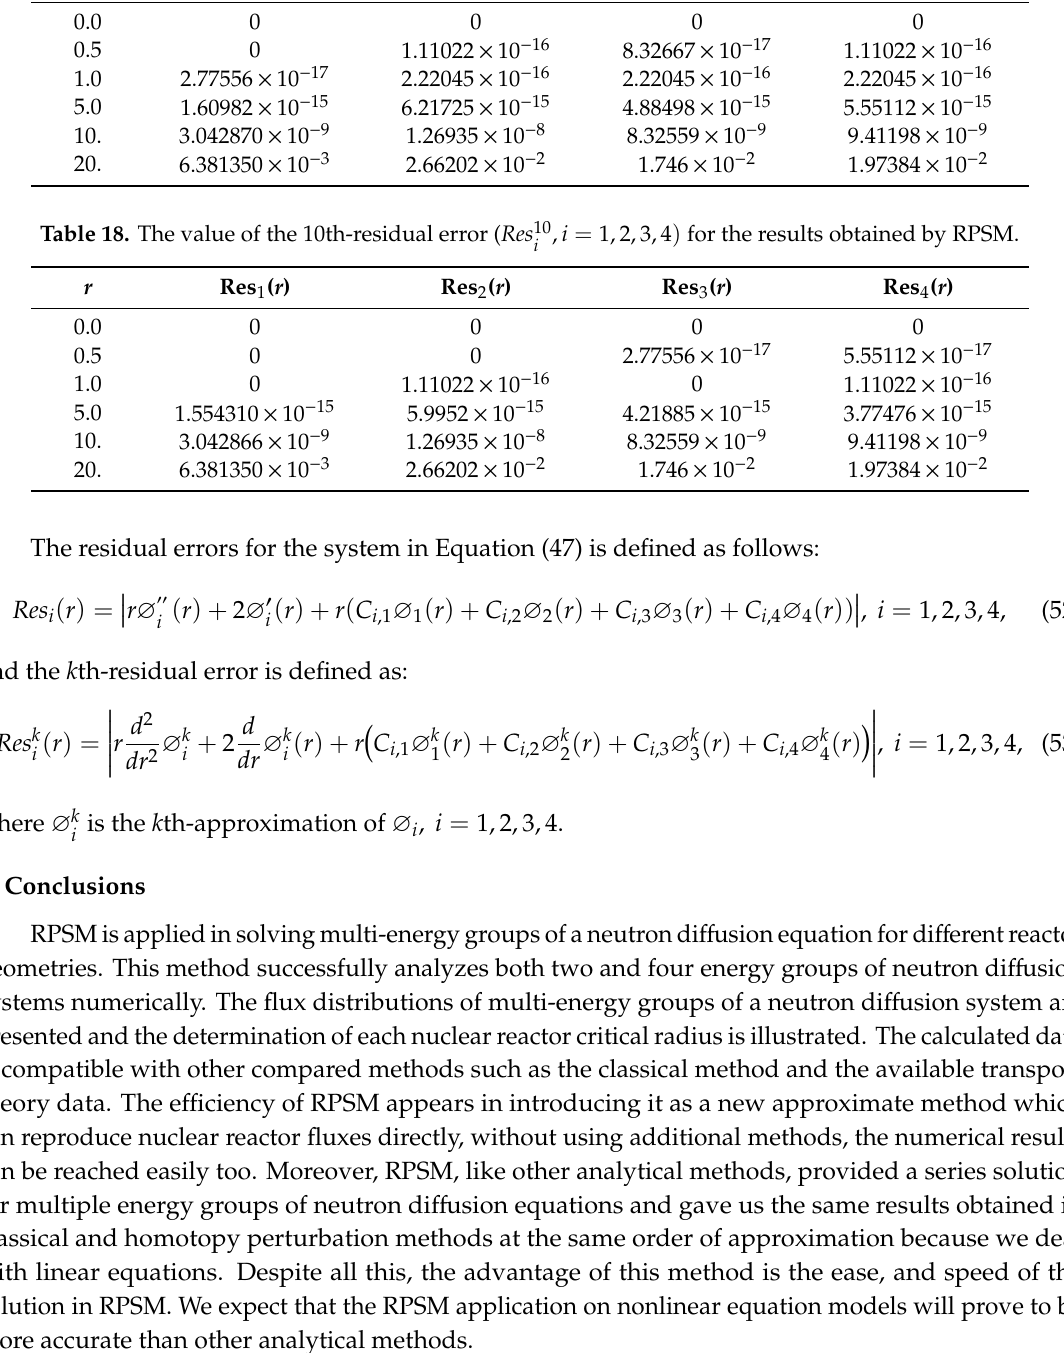
, i = 1,2,3,4 ) for the results obtained by i